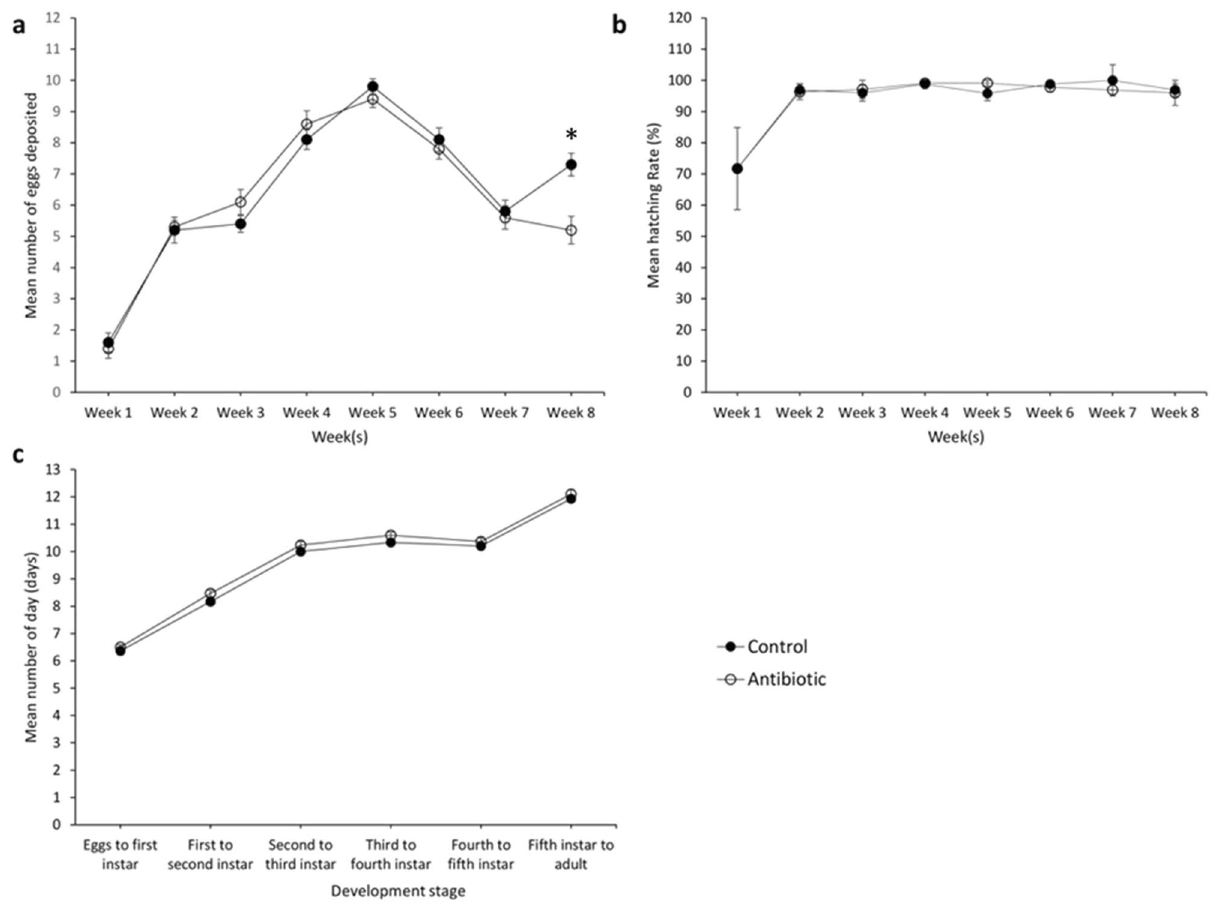
Figure 1. Effects of antibiotic treatment on different life history traits of C. hemipterus . ( a ) fecundity; ( b ) hatching rate; ( c ) nymphal development. Asterisk denotes significant difference, P < 0.05 (independent